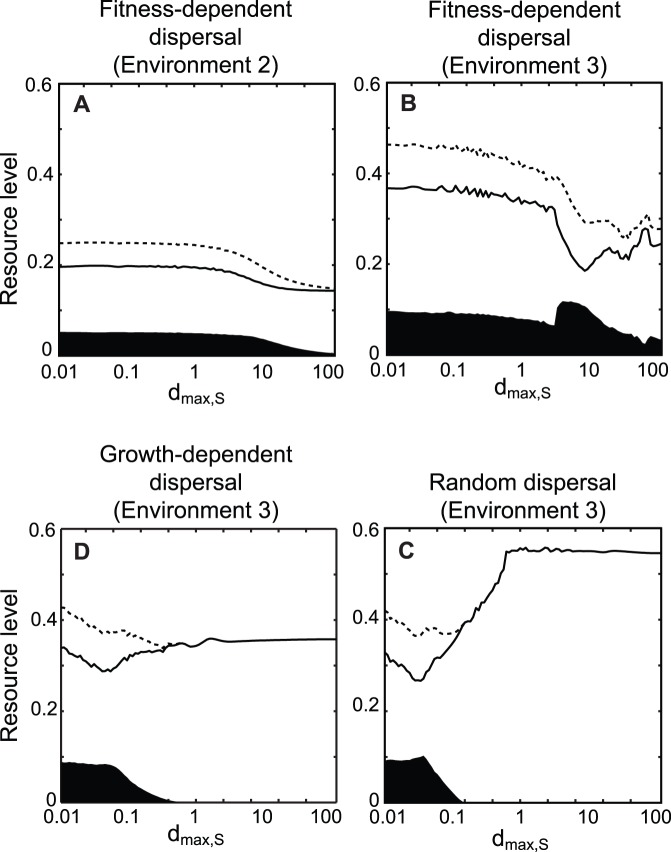
The effect of the superior consumer moving capacity (dmax,S) on resource dynamics.The effect of the superior consumer moving capacity (dmax,S) on resource dynamics when the inferior consumer is absent. These are the resource dynamics that the inferior will face as they invade the community where only the superior resides. Each panel shows the average resource level in patch 1 (, bold lines; for all four cases), average ideal resource level (, dotted lines), and the potential advantage of fitness-dependent dispersal (, shaded).